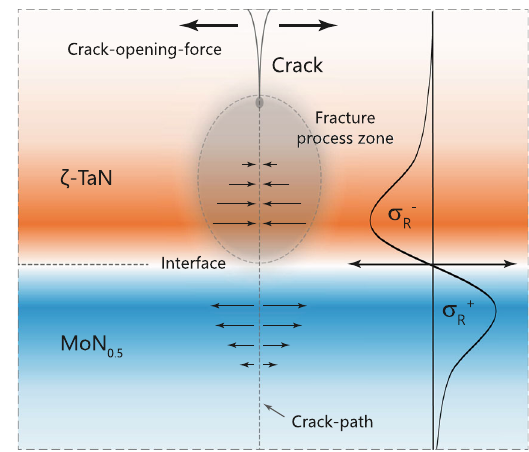
Fig. 7 Illustration of a fracture process in superlattice thin fi